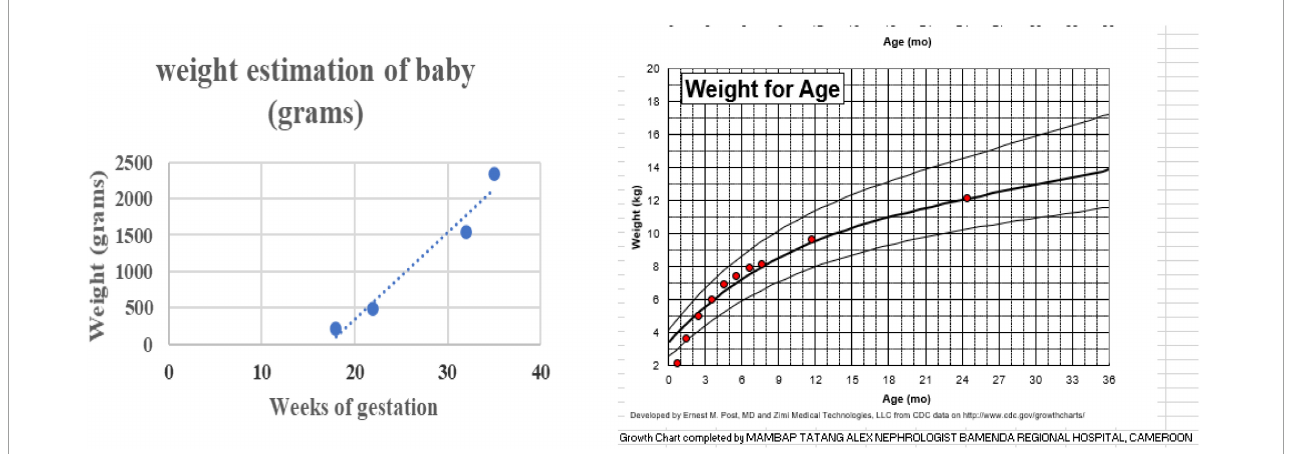
FIGURE3 Intra-uterine and extra-uterine weight change of the